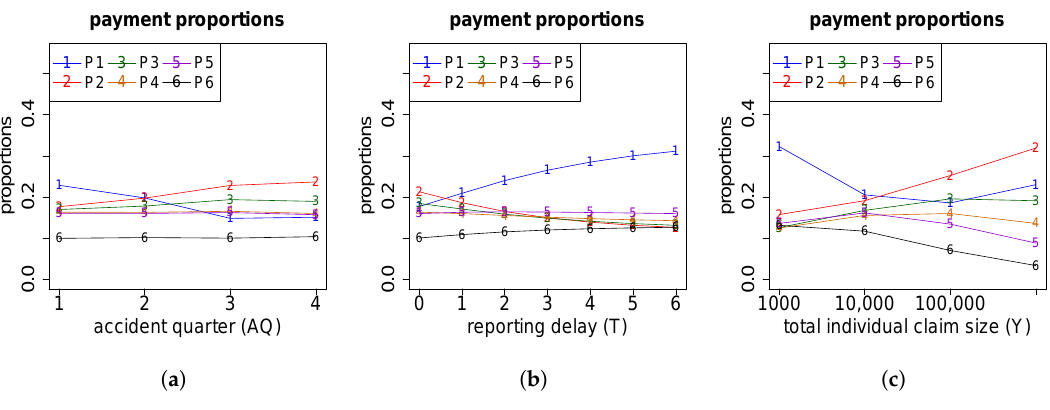
Figure A13. Proportions P ( 1 ) , . . . , P ( 6 ) of the total gross claim amount Y + Y − paid in the K + = 6 positive payments w.r.t. the features ( a ) AQ ; ( b ) reporting delay T and ( c ) total individual claim size Y